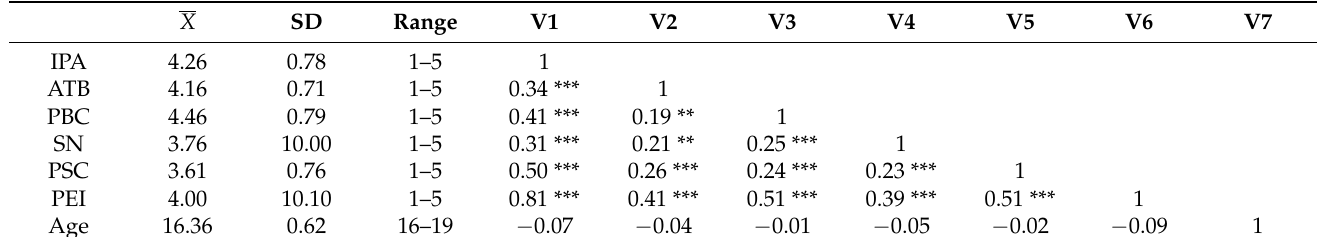
Table 2. Analysis of means, reliability ( α ), and correlation between variables with the intention of being physically active after completing secondary